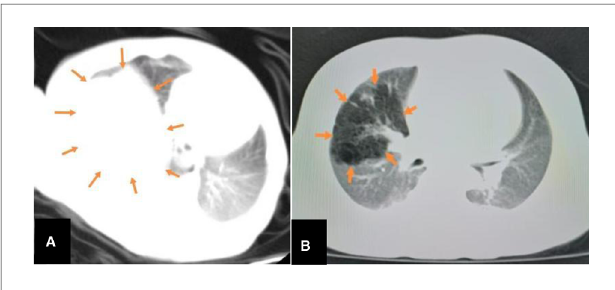
FIGURE 5 The comparison between CT features FLIT and CPAM. CT shows a mass (arrows) with uniform density in FLIT ( A ) and a mass (arrows) with low- density cystic spaces in CPAM ( B